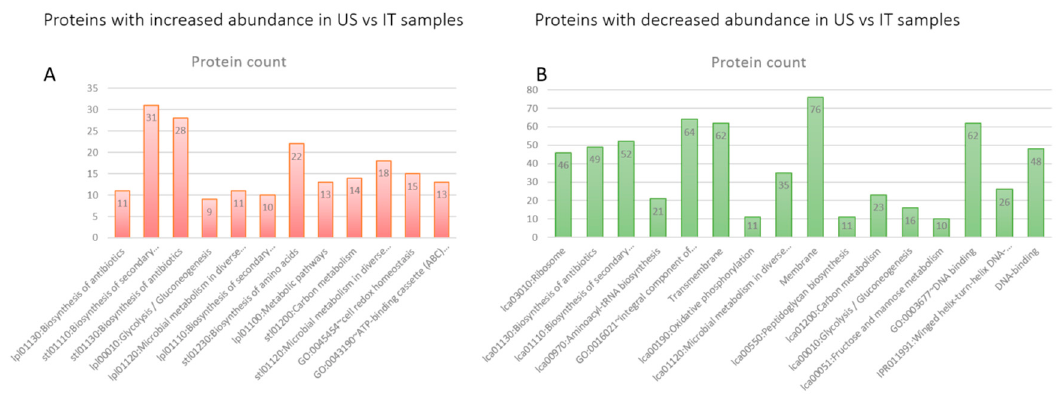
Figure 4. Database for Annotation, Visualization, and Integrated Discovery (DAVID) enrichment analysis of proteins with increased abundance in US-( A ) and IT-products ( B ).